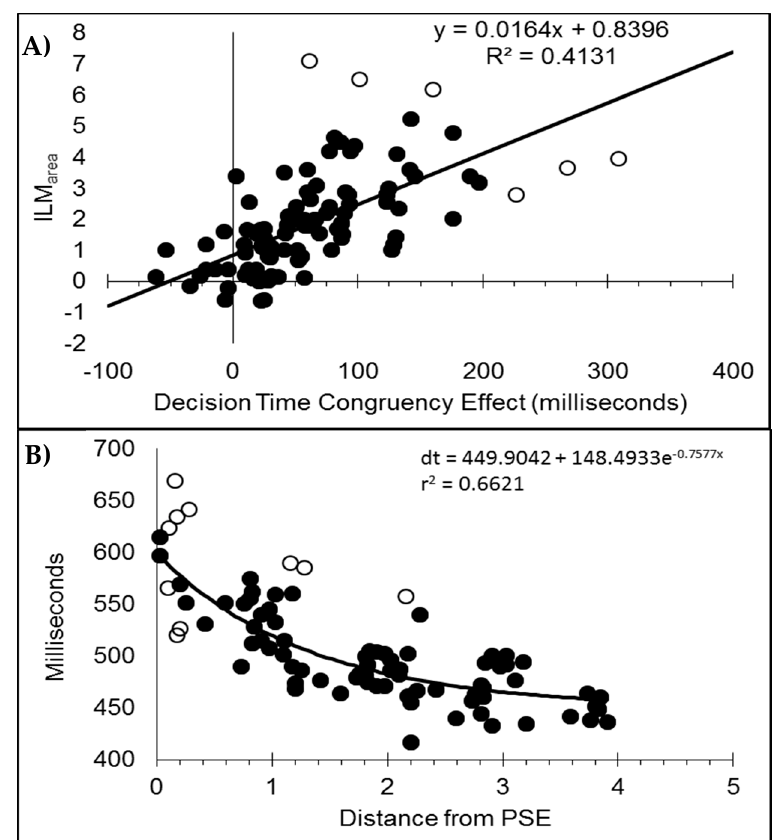
Figure 4. Scatterplots showing the ( A ) correlation between the decision time congruency effect and ILM area , and ( B ) the exponential distance decay function relating the decision times to the distance from the point of subjective equality from Experiment 1. The open symbols indicate data pairs that exceeded the Cook’s Distance inclusion criterion.